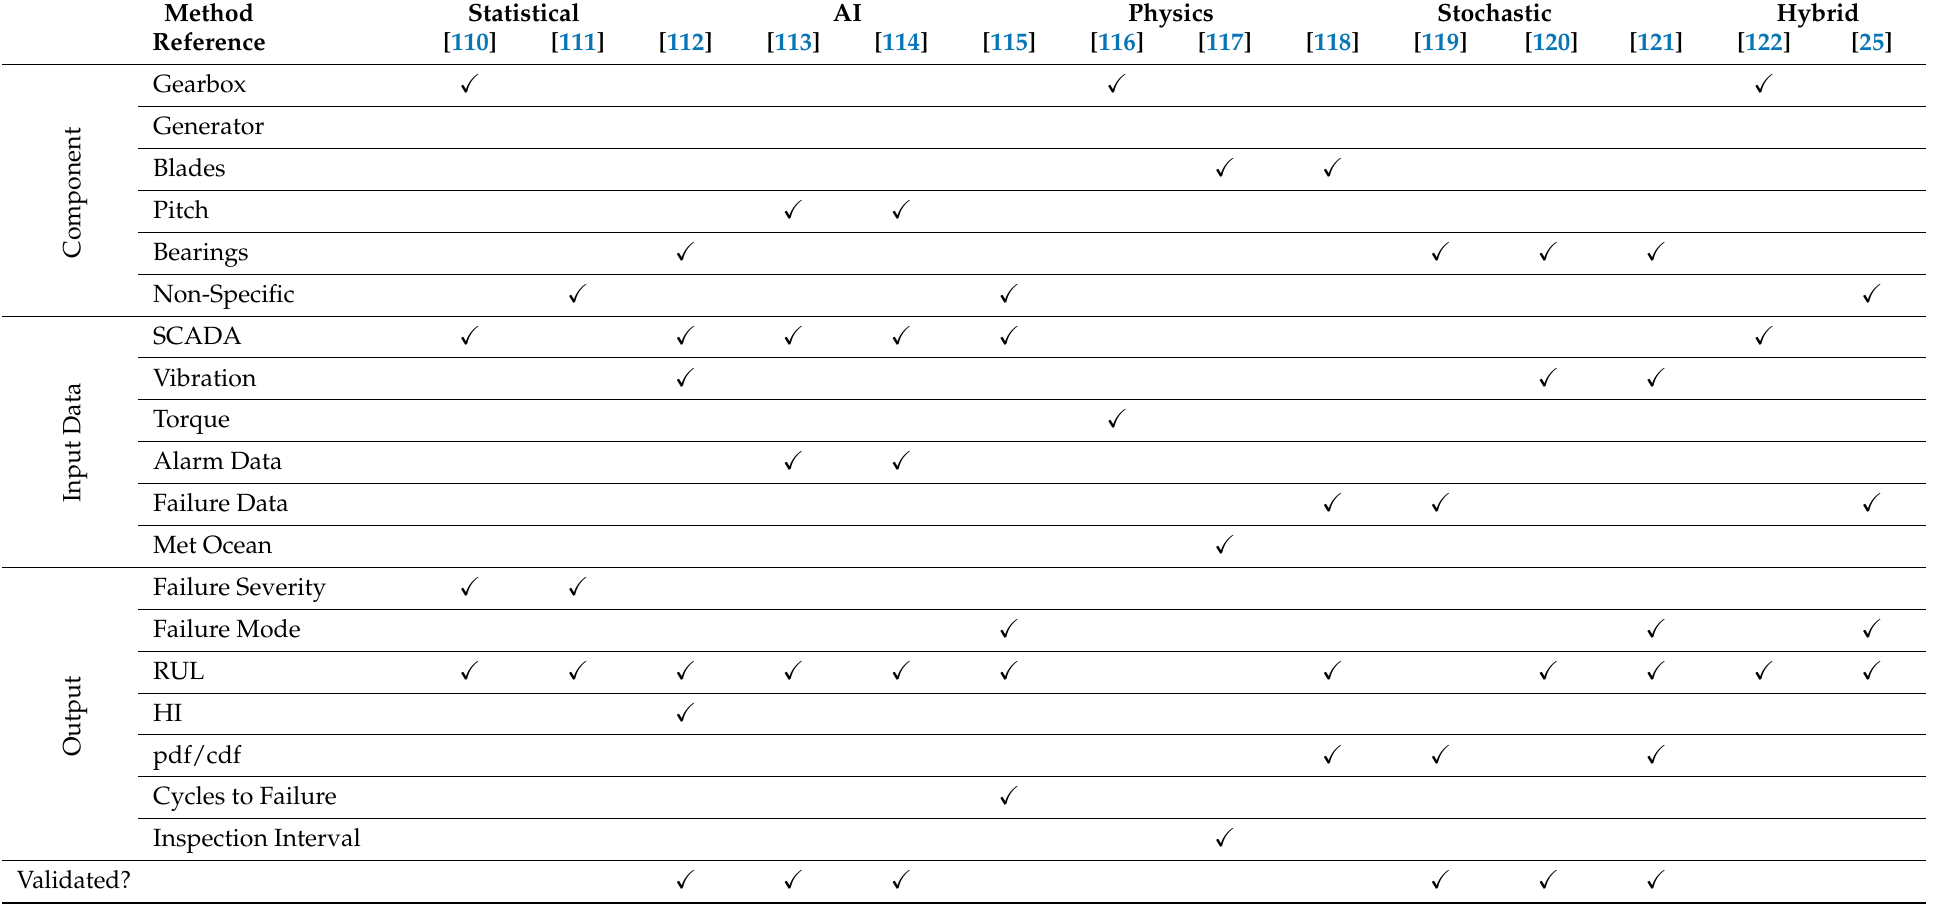
Table 3. Summary of references considered in Section 4.5 regarding failure